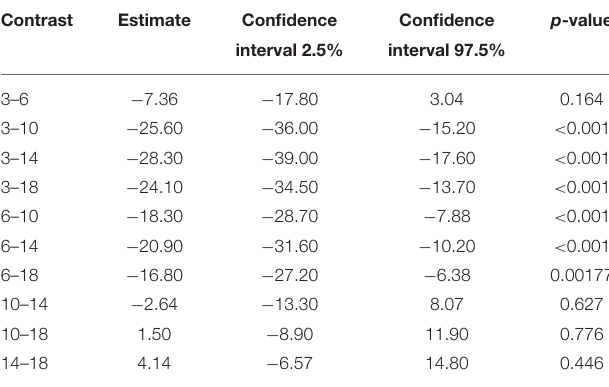
TABLE 7 | The difference in estimated marginal means (contrast) between the time to maximum concentration of carprofen in the respective cage sizes. Contrast